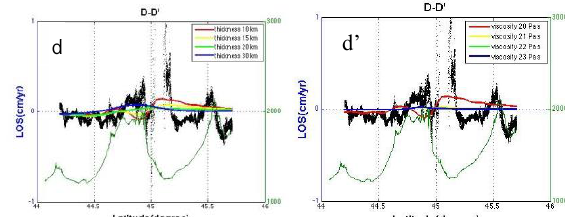
Figure 7. Velocity profile plots across the main strike slip fault along A-A’, B-B’, C-C’, D-D’ (lines shown in Figure 2). The black dots show the line-of-sight displacement rates (cm/yr) from the InSAR data, and the colored lines show the different models corresponding to increasing upper layer thickness (10 km, 15 km, 20 km, 30 km) and viscosity (1×10 20 Pa s, 1×10 21 Pa s, 1×10 22 Pa s, 1×10 23 Pa s) respectively. The best fitting viscoelastic relaxation model is for H = 10 km with 1×10 20 Pa s viscosity, always shown by the red line of the model profiles. The second y-axis at the right side shows the elevation (m), the dark blue line in the profile displays the elevation plot.